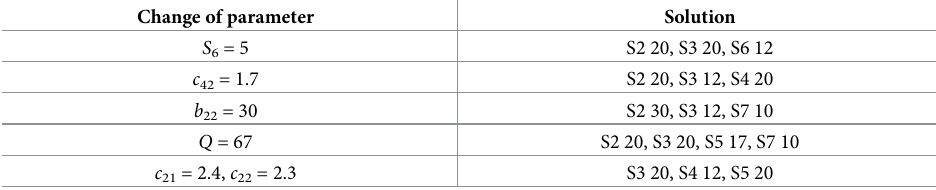
Table 17. Solutions of the numerical example by changing its